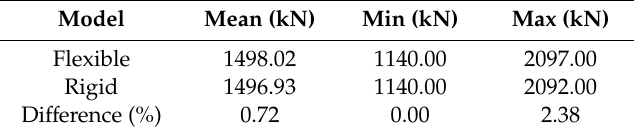
Table 4. Comparison of statistical data (slack mooring line).